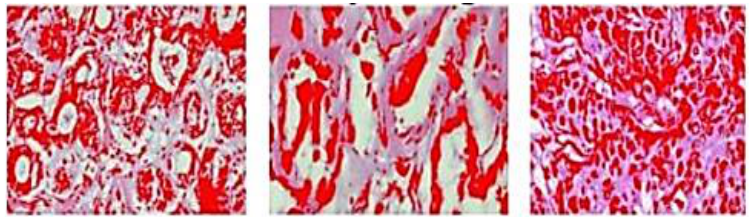
Figure 13. The experimental result. Segmented images of proposed DNNS method [104].